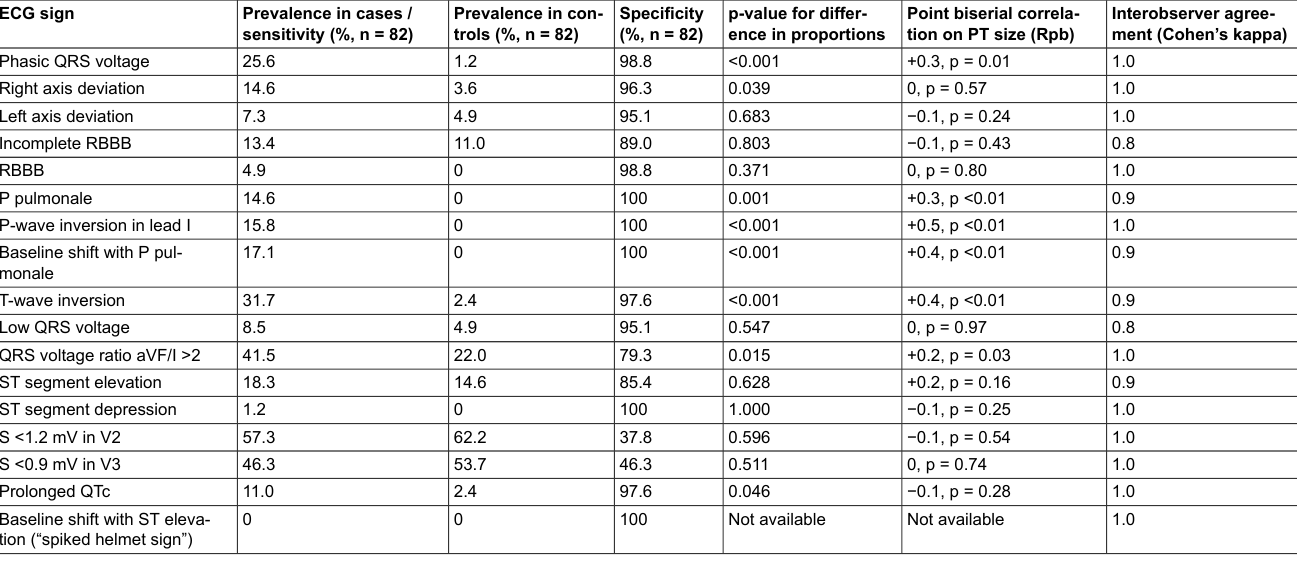
Table 2: Sensitivity and specificity for the presence of pneumothorax for different ECG signs and point biserial correlation with pneumothorax and size. ECG sign Prevalence in cases /